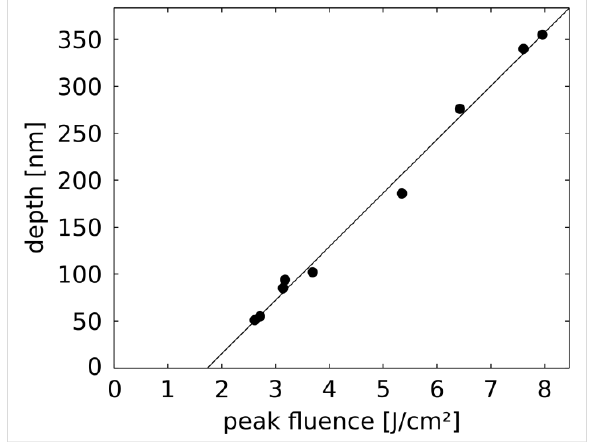
Figure 10: Depth of holes in Si, generated by far-field ablation, as a function of the peak fluence.